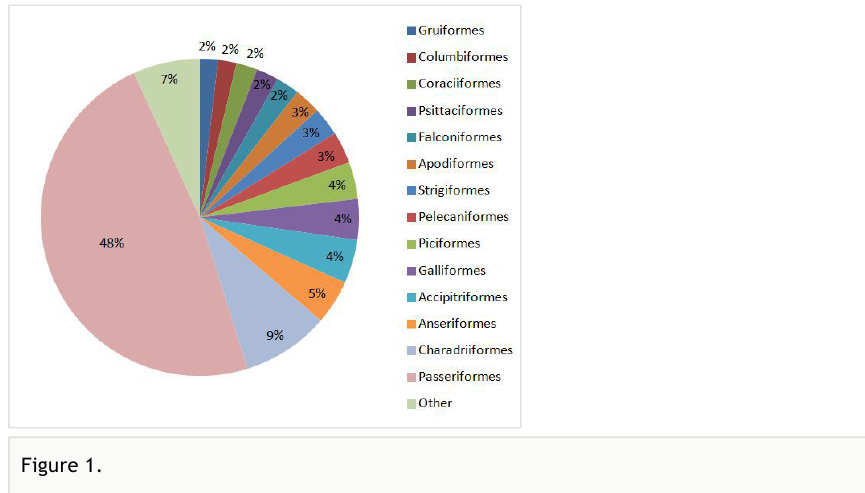
Distribution of the avian specimens represented in the ZMUA collection to taxonomic